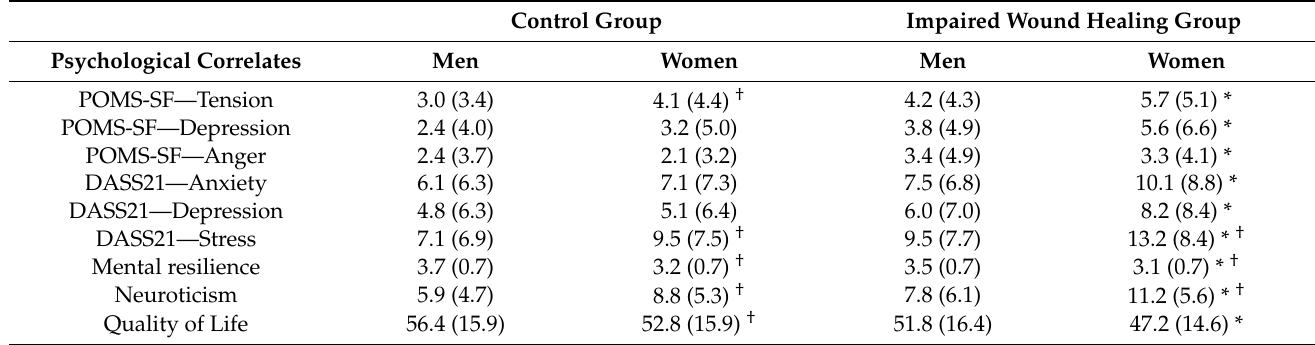
Table 3. Psychological correlates of impaired wound healing according to sex. Control